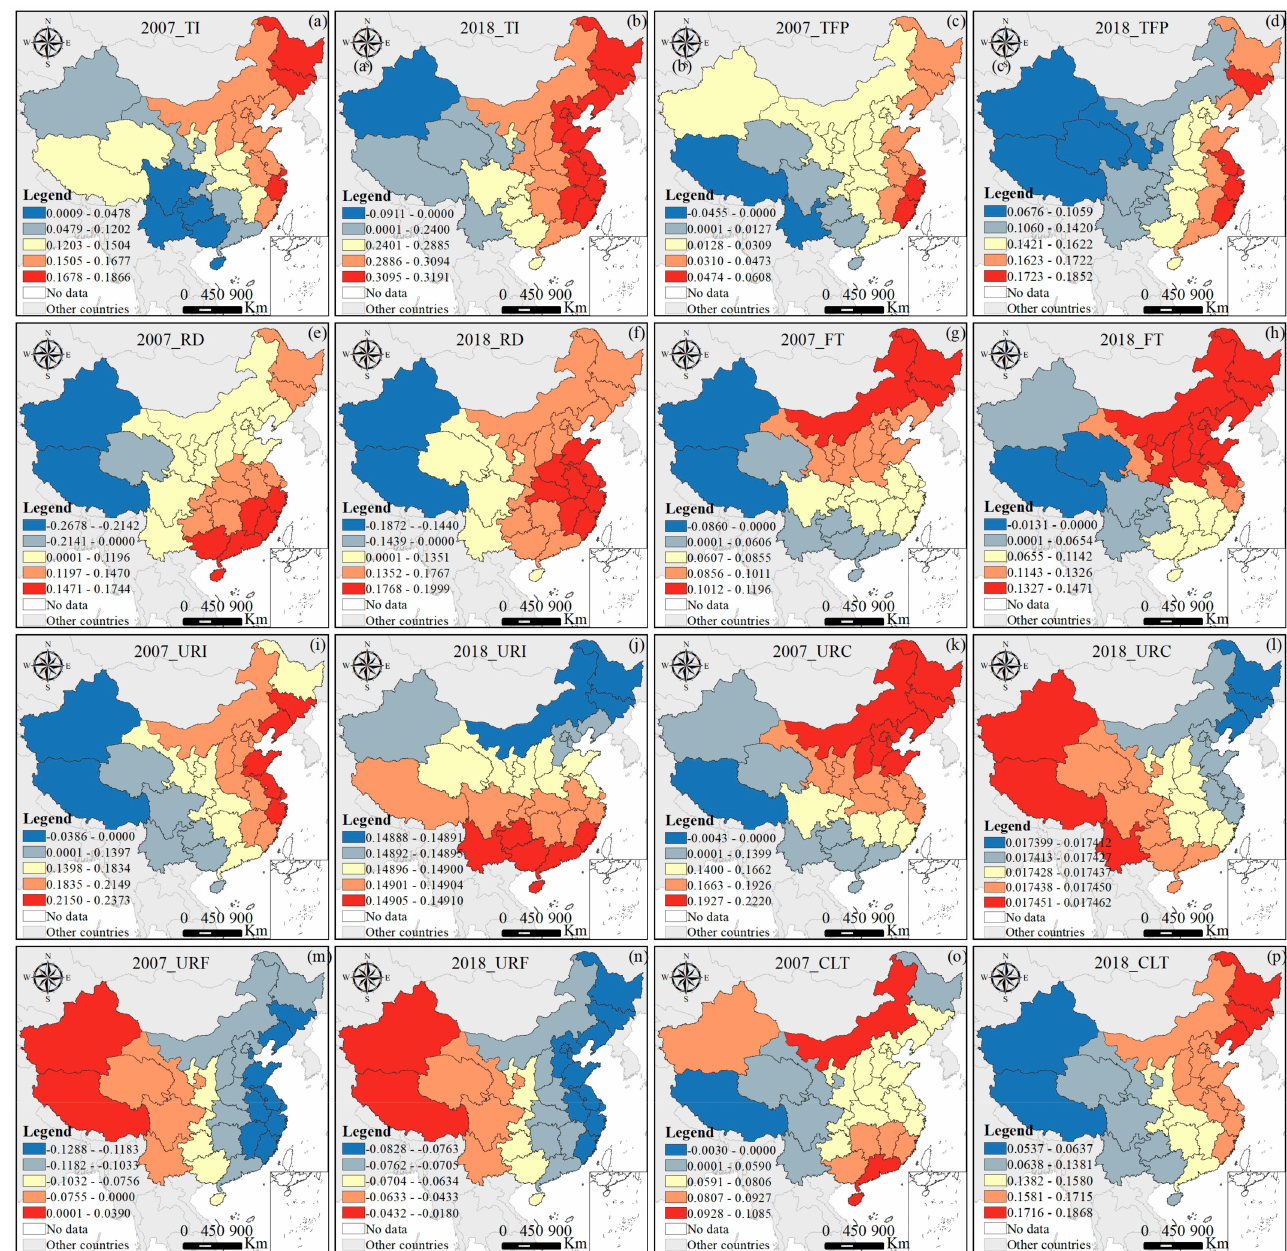
Figure 7. ( a – p ) Spatial distribution of regression coefficients of driving factors during 2007–2018. (Source: made by